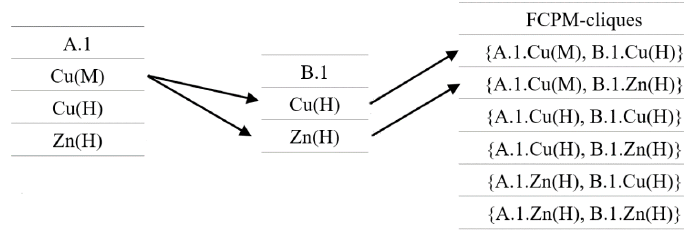
Figure 8. An example of constituting FCPM-cliques.